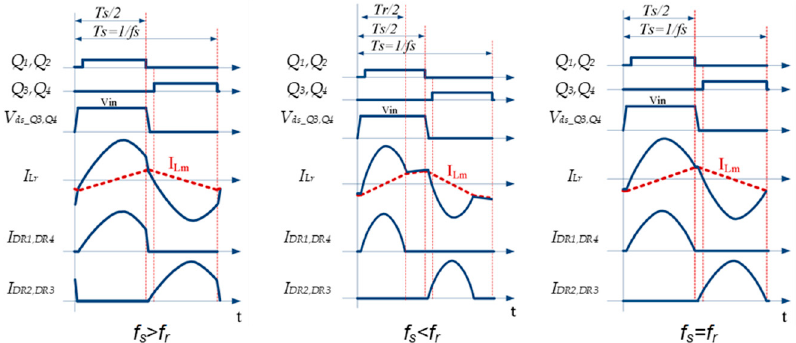
Figure 7. Voltage and current waveform according to switch on/o ff .